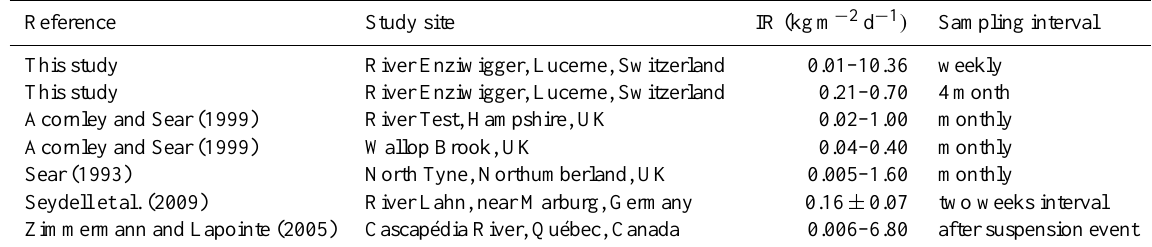
Table 3. Range or mean ± standard deviation of infiltration rate (IR) of sediment < 2mm in permeable sediment baskets.